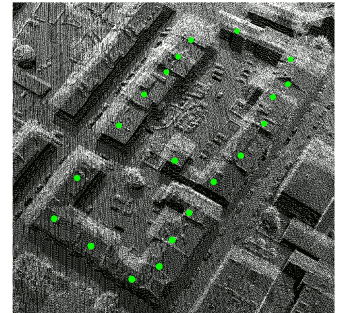
Figure 2a. 3D point cloud with address points.